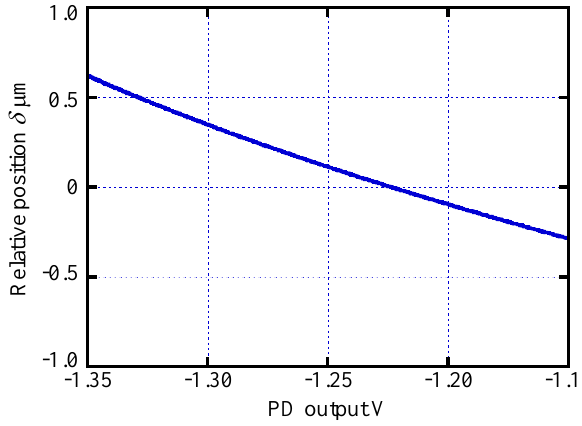
Figure 7. Relationship between the PD output and the y -directional relative position of the optical probe with respect to the flat-shaped cutting edge.